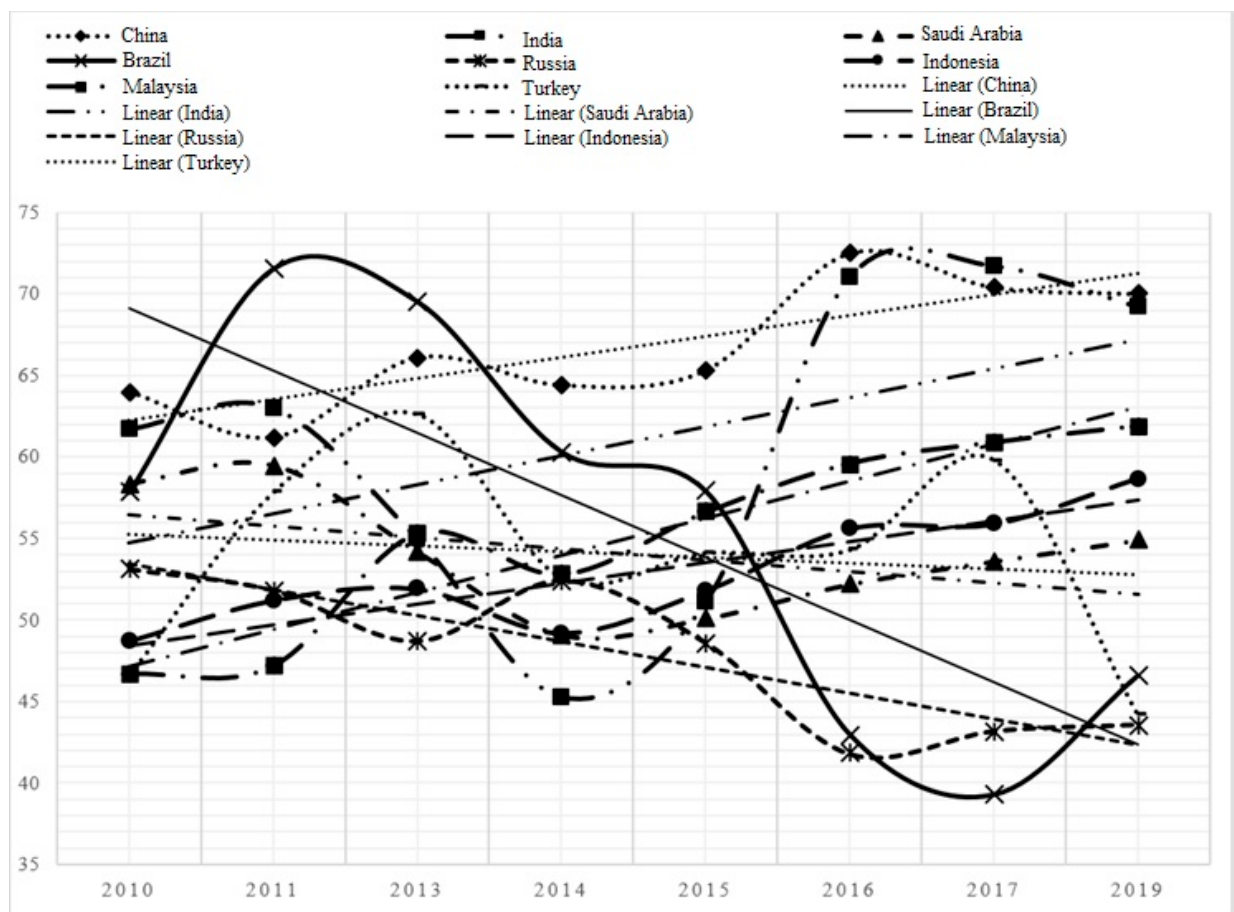
Figure 4. Global Retail Development Index (GRDI) by countries (developed by the authors based on data from Kearney Global Retail Development Index: https://www.kearney.com/global-retail-development-index). In Russia and Brazil, on the contrary, the country attractiveness profiles for further advance of global retail chains have been declining. This adds to evidence that global re- tailers are gradually exhausting their potential as a factor of convergence of buying and consumption behaviours. These countries have nearly reached developed countries by the level of penetration of global retail chains and, accordingly, in terms of convergence of buying and consumption behaviours. However, in contrast to developed countries, these countries see intensifying rivalry not only among national retail chains competing with each other but also among global chains competing with each other and national chains. A comparative analysis of Russia’s attractiveness profile vs. average values of GRDI for 30 countries included in the assessment of attractiveness for retail chain development indicates higher rates of deterioration in the Russian Federation in terms of attractiveness for further advance of global retail chains (Figure 5).